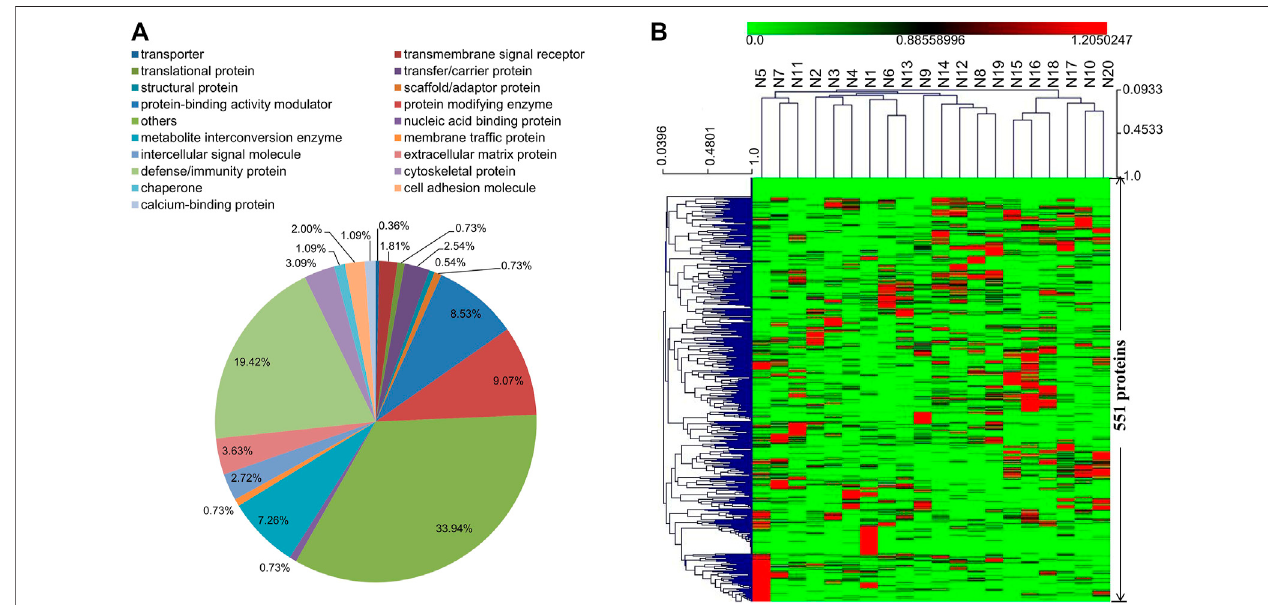
FIGURE1|(A) Functionalclassi fi cation oftheidenti fi ed 551proteins inserum samples(N1 – N20) using thePANTHER classi fi cation system(www.pantherdb.org). (B) Hierarchical clustering analysis of the identi fi ed 551 proteins in serum samples (N1 – N20).